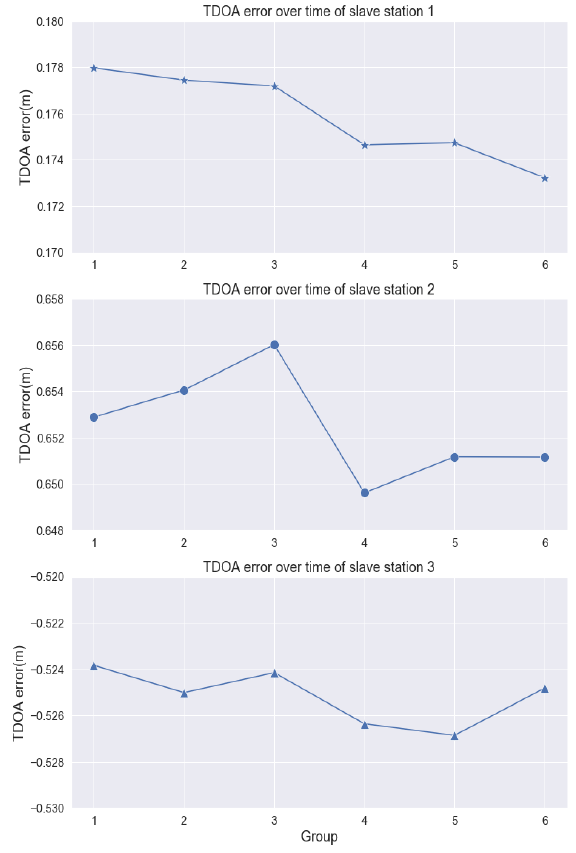
Figure 7. Fluctuation of the average TDOA error in non-disturbed